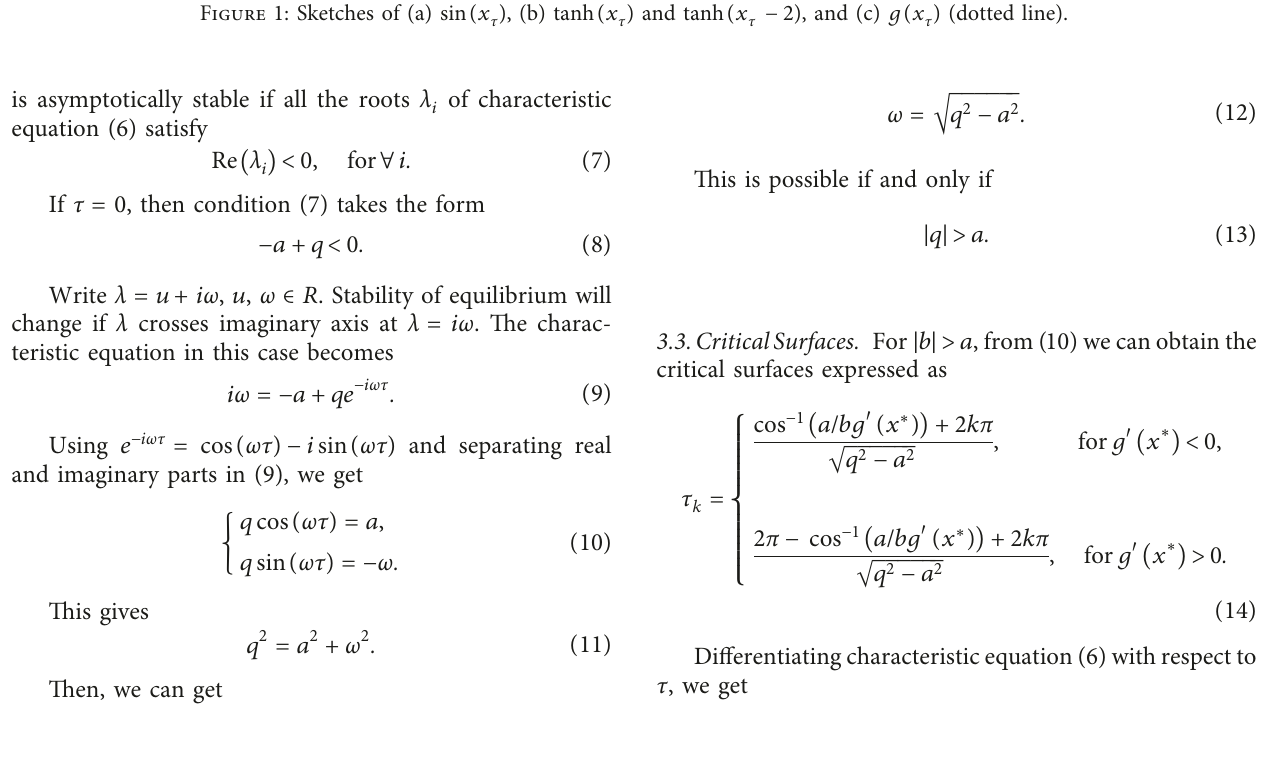
Figure 1: Sketches of (a) sin ( x